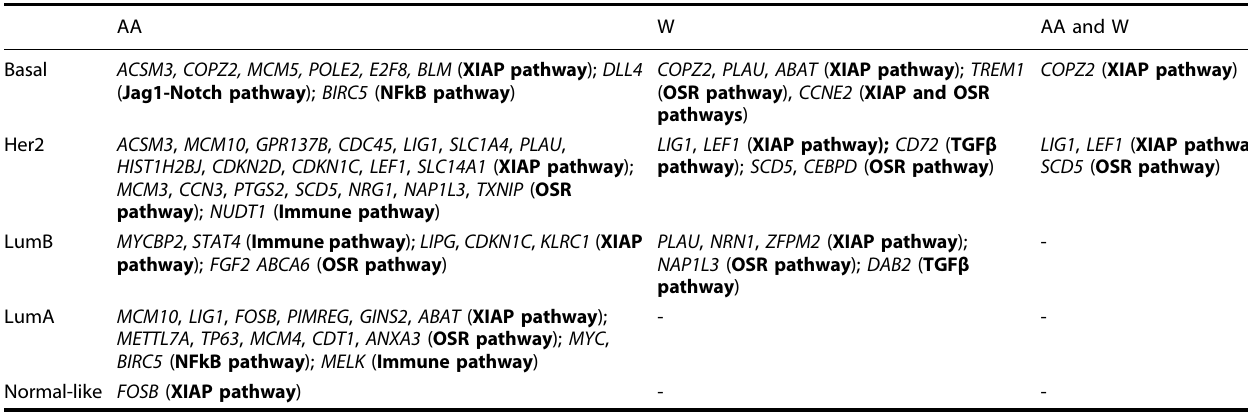
Table 3. DE-SN associated with patient overall survival in AA only, W only, or both AA and W. AA W AA and